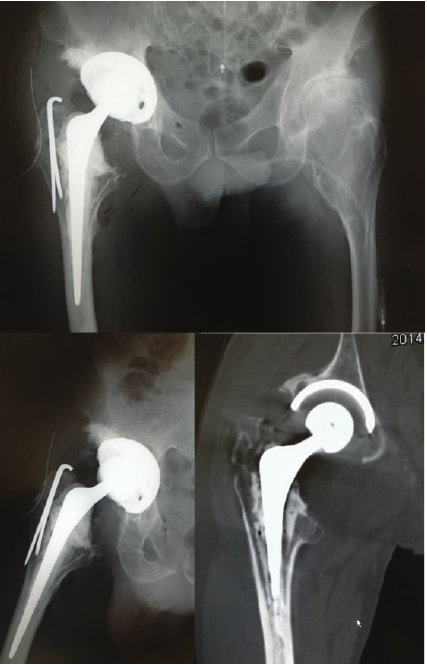
Figure7:Postoperativeradiographsandmultidirectionalcomputed tomography imaging showing that the implant setting was unprob- lematic, and the exostosis at femoral neck had been removed.